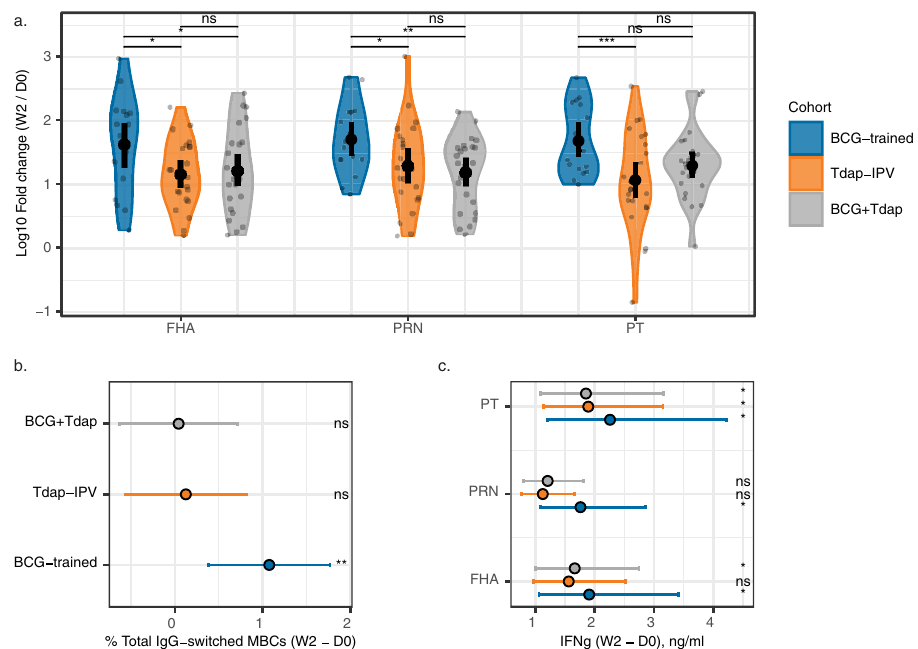
Fig. 2 Prior BCG vaccination enhances pertussis-speci fi c antibody, IFNg, and total memory B cell responses 2 weeks following Tdap-IPV vaccination. a Violin plots showing log10 fold change (W2/D0) of pertussis toxin (PT), pertactin (PRN), and fi lamentous haemagglutinin (FHA) -speci fi c IgG responses, data are N = 16 – 25 per cohort. b Differences in total IgG-switched memory B cell (MBC) responses (W2 – D0), data are N = 15 – 16 per cohort, and c differences in IFNg produced in response to PT, PRN, or FHA stimulation of peripheral blood mononuclear cells (W2 – D0), data are N = 16 – 25 per cohort. P -values, signi fi cance, and estimates were calculated with a linear mixed model fi tting each primary outcome with time, cohort, and their interaction as main effects. Sample means are plotted with 95% con fi dence intervals (solid black point and line), * p < 0.05; ** p < 0.01; *** p < 0.001; ns not signi fi